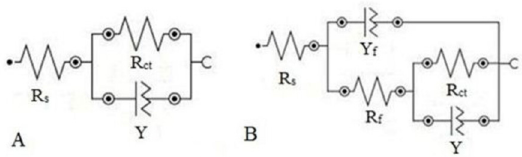
Figure 7. Equivalent circuit models used to simulate the EIS data of (A) the bare carbon steel substrate and (B) the Cu-Sn coating/ substrate systems.